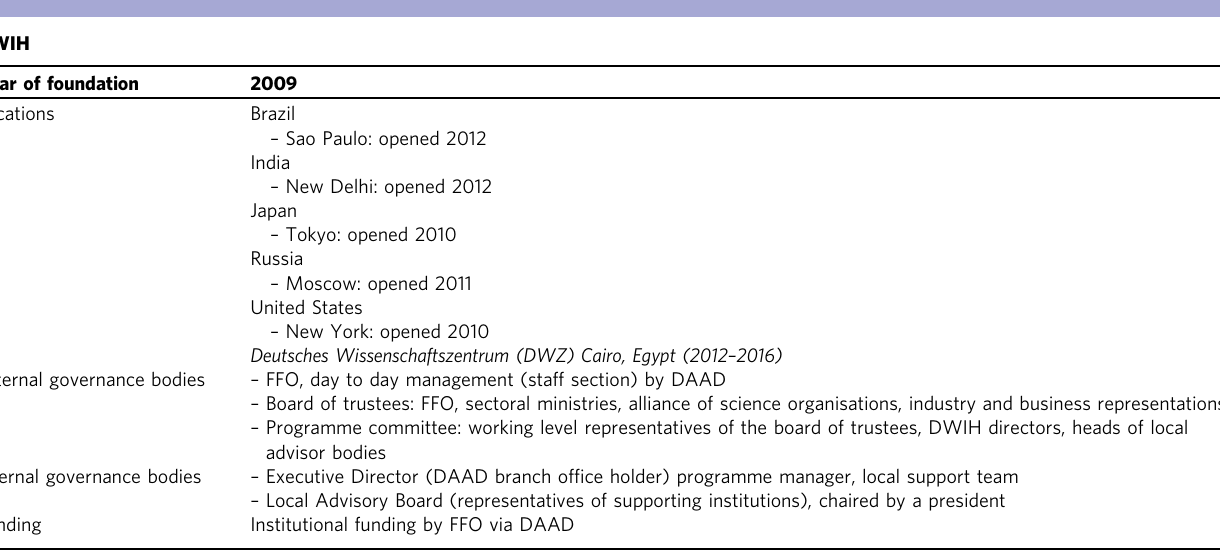
Table 1 Key characteristics